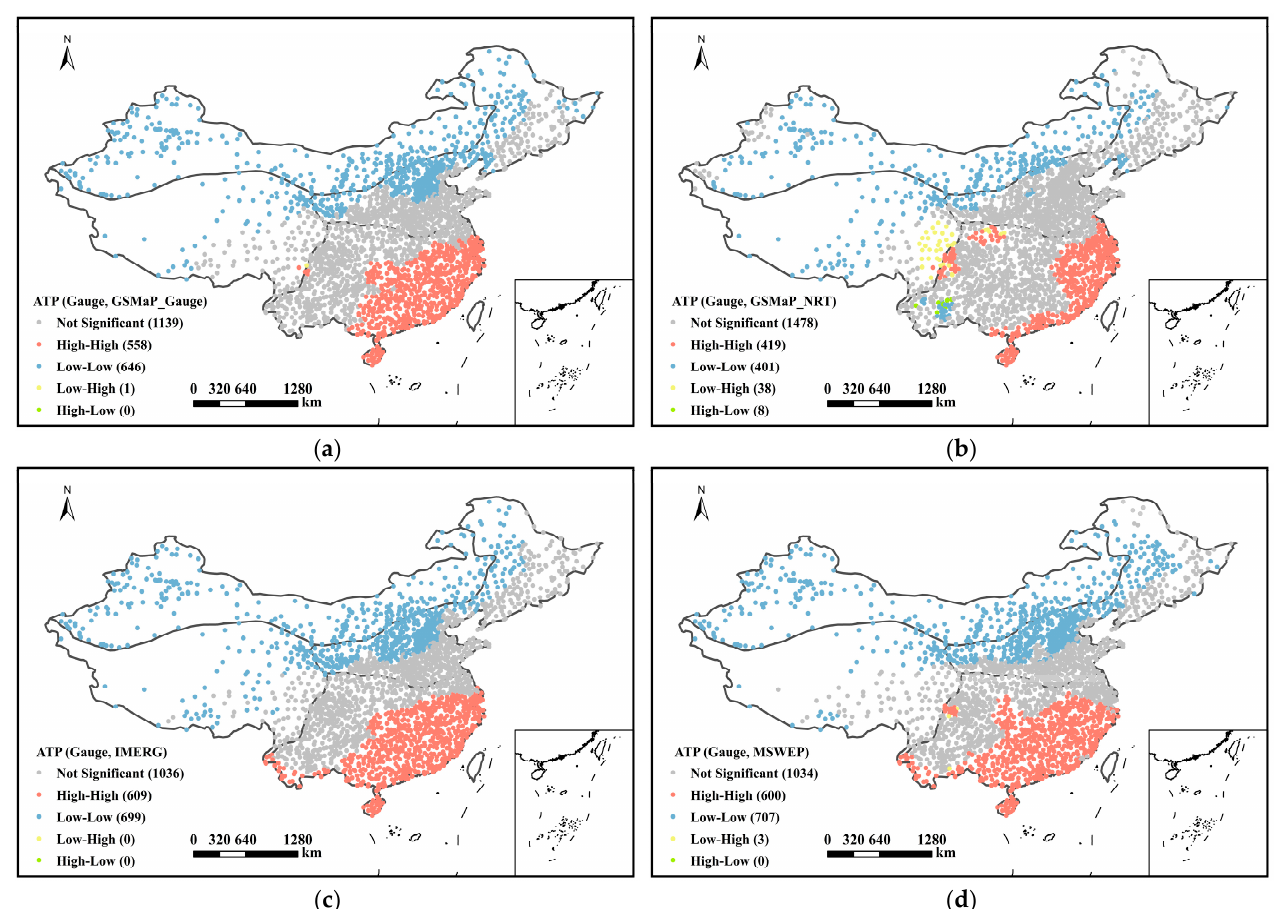
Figure 4. The LISA cluster maps of ATP between the gauge observations and the four SPPs and the number in the bracket represent the corresponding number of gauges: ( a ) GSMaP_Gauge, ( b ) GSMaP_NRT, ( c ) IMERG, and ( d ) MSWEP.